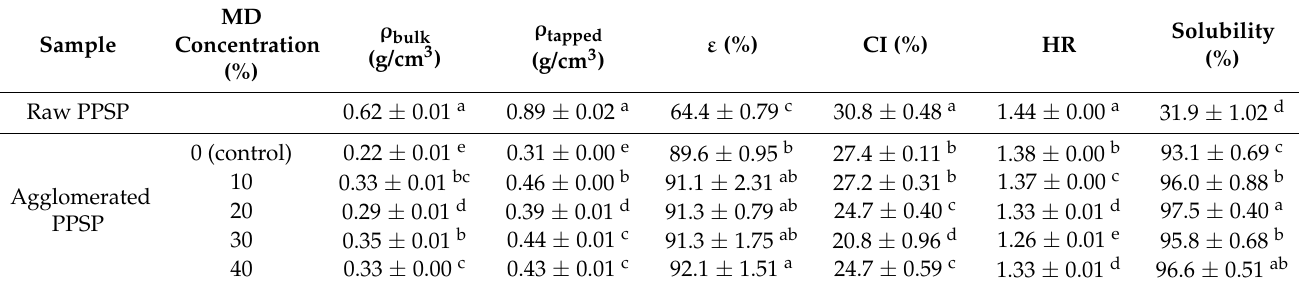
Table 2. Flow characteristics, porosity ( ε ), and solubility of raw and agglomerated PPSPs with different concentrations of MD